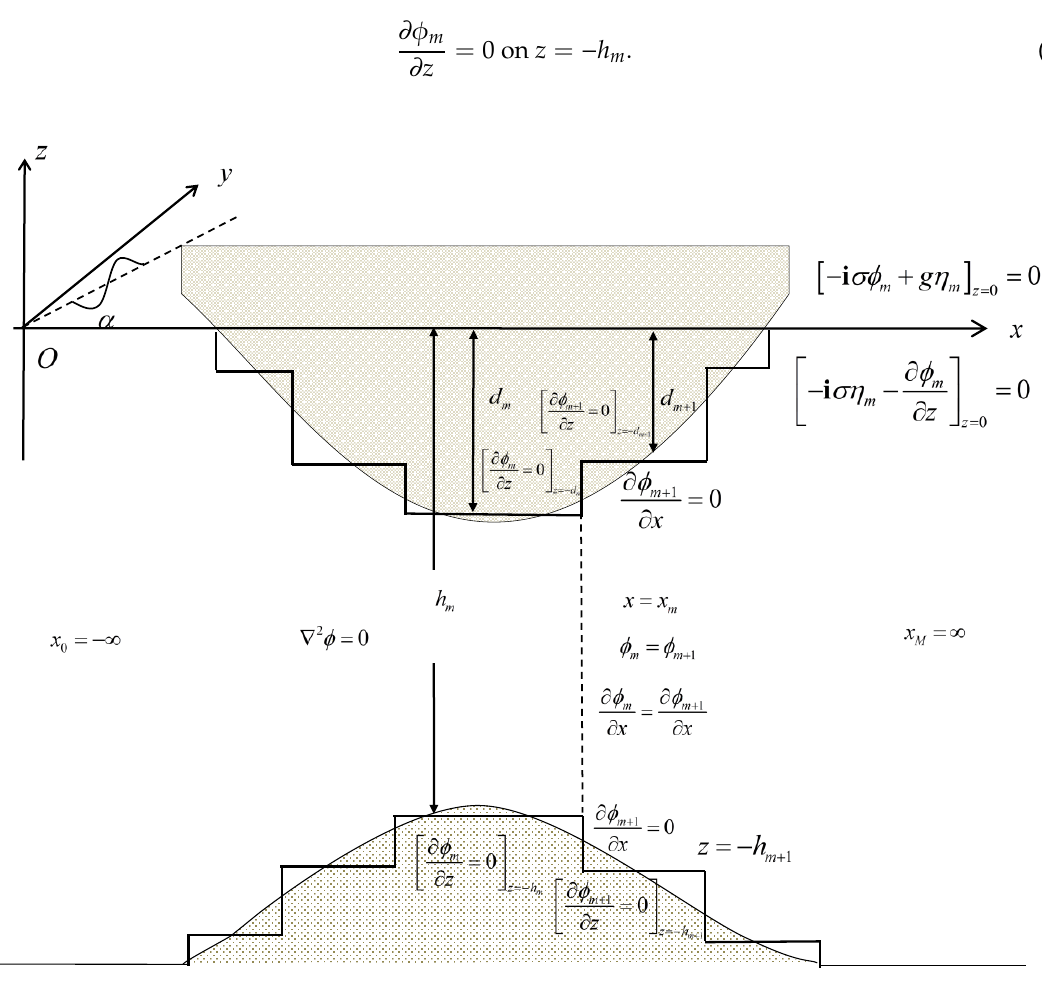
Figure 1. Schematic representation of the boundary-value problem of water-wave-scattering by the surface-piercing structure over even bottom. The study domain divided into di ff erent regions with M shelves separated by M − 1 steps.